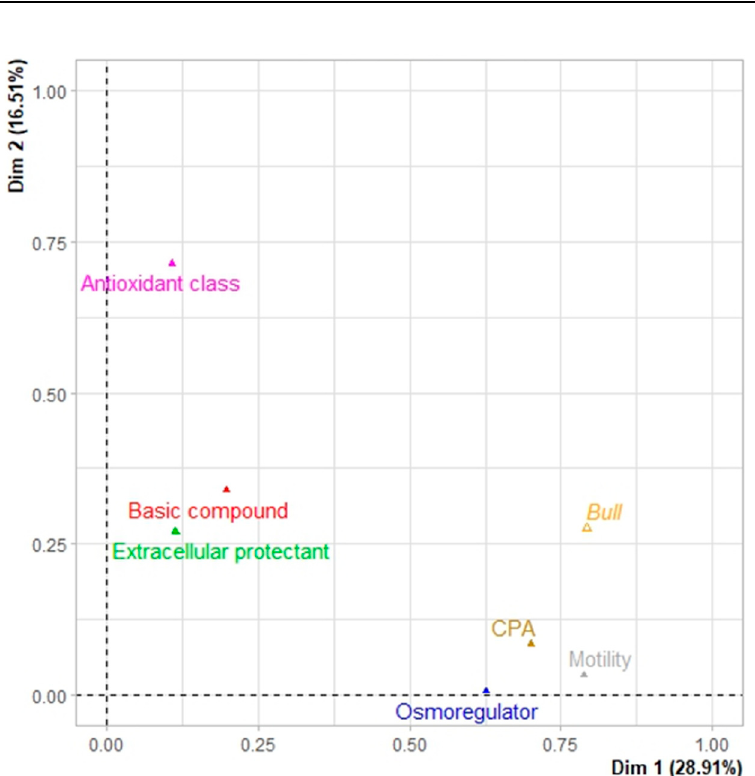
Figure 5. A contribution biplot of composite parameters on dimensions 1 and 2 after analysis of active groups (basic compound, extracellular protectant, CPA, osmoregulator, antioxidant class, and motility) and the supplementary variable (bulls).